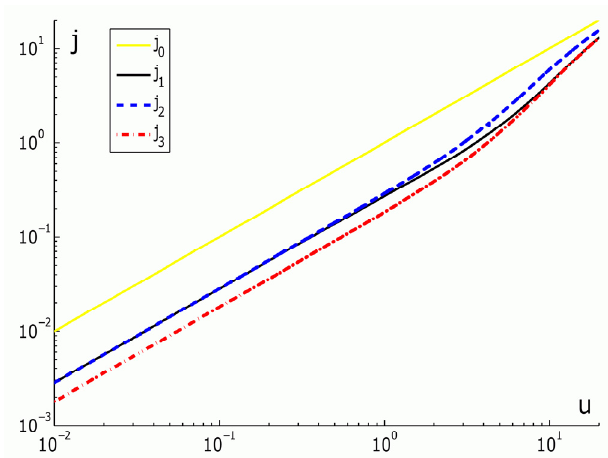
Fig. 3: The double logarithmic current density versus voltage plot of the three energy profiles (asymmetric triangular profile, j 1 , symmetric triangular profile, j 2 , trapezoidal profile, j 3 ) and bulk current density ( j 0 ) for an energy barrier height of w =2.15 (in kT units), a relative size of the entrance region of the pore of r =0.3, and voltage u >0 ( kT/q units). This plot mainly shows the linear behavior of the current densities at small